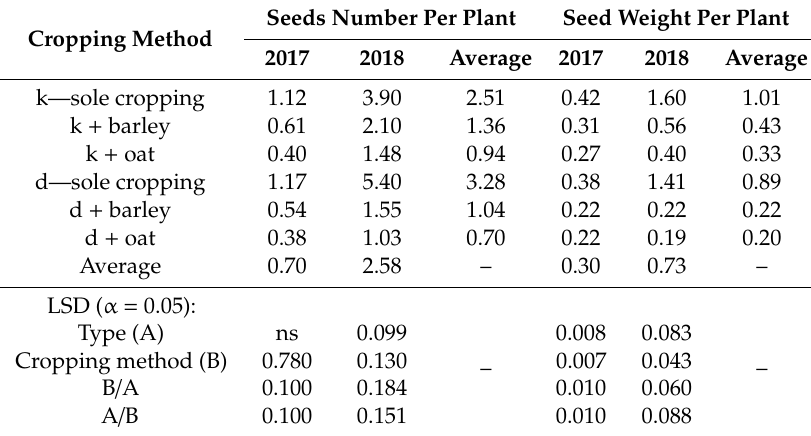
Table 5. Dry weight stem of one plant (g) and siliques (g), depending on cropping method and